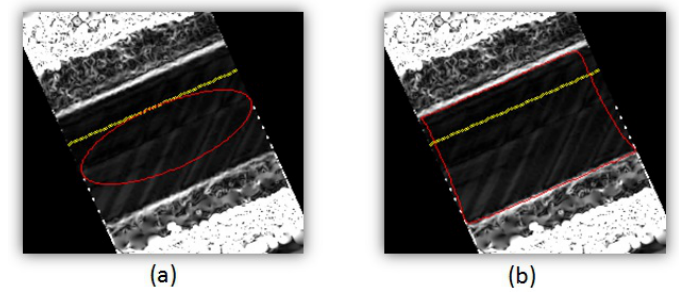
Figure 9. An ( a ) initial and ( b ) final position of the snake